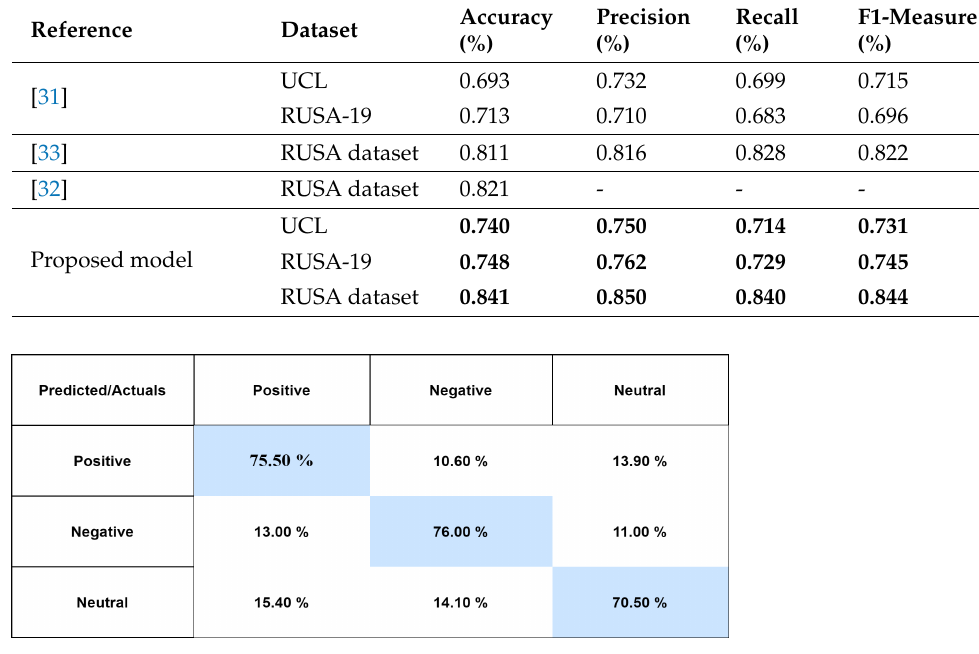
Figure 5. Confusion matrix of CNN-LSTM Roman Urdu sentiment analysis with UCL corpus.